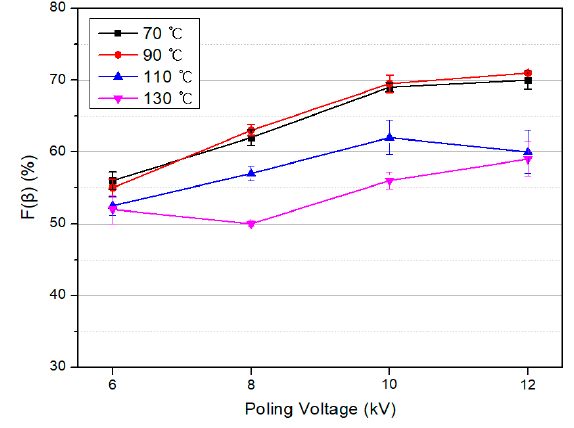
Figure 10. Relative intensity of the β crystalline phase in the PVDF/PAR composites as a function of the poling voltage.